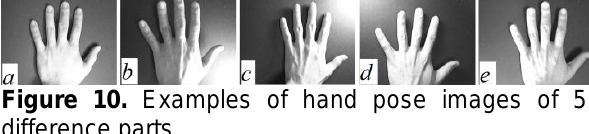
Figure 10. Examples of hand pose images of 5 difference parts